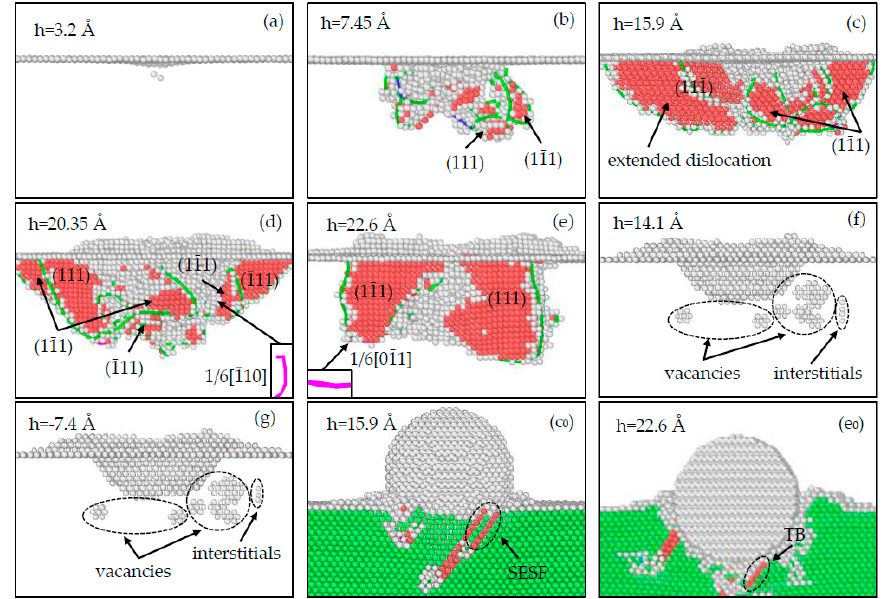
Figure 4. Defect evolution in the (100) sample during the loading process ( a – g , c 0 , e 0 ), and the unloading process ( f – g ). (SESF is the external stacking fault, TB is the twinning boundary).